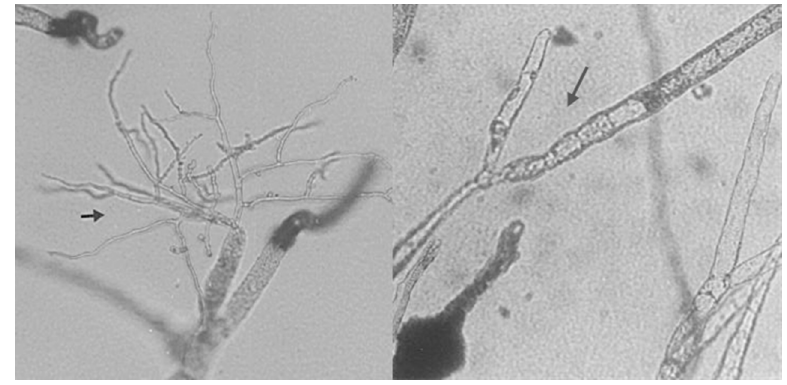
Figure 7. Branching ( left ) and vacuolated ( right ) mycelia of Mucor mucedo . Grown in dual culture with L. muscarium (modified from [19]).